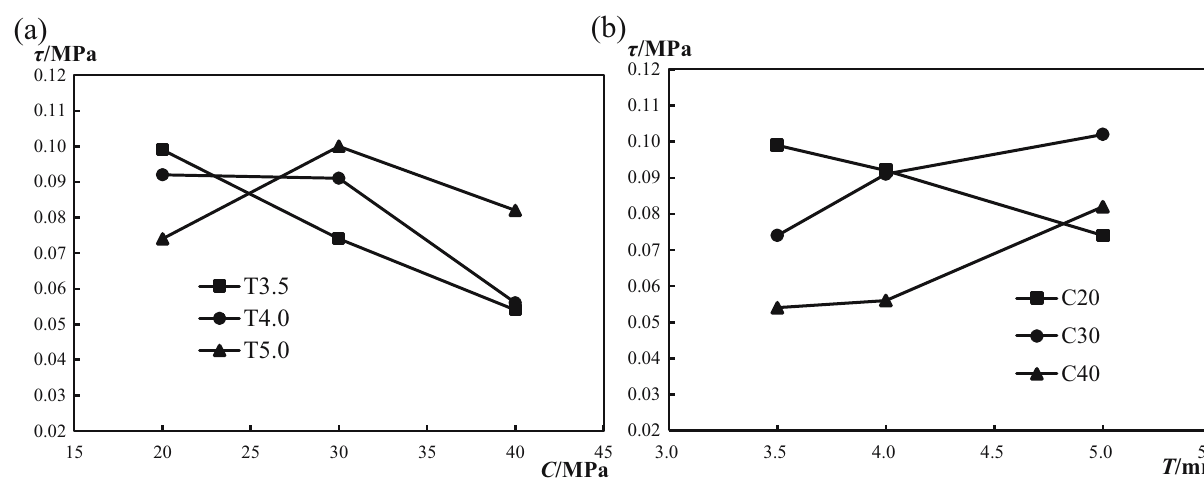
Figure 9: E ff ects of the ( a ) concrete strength and ( b ) GFRP tube